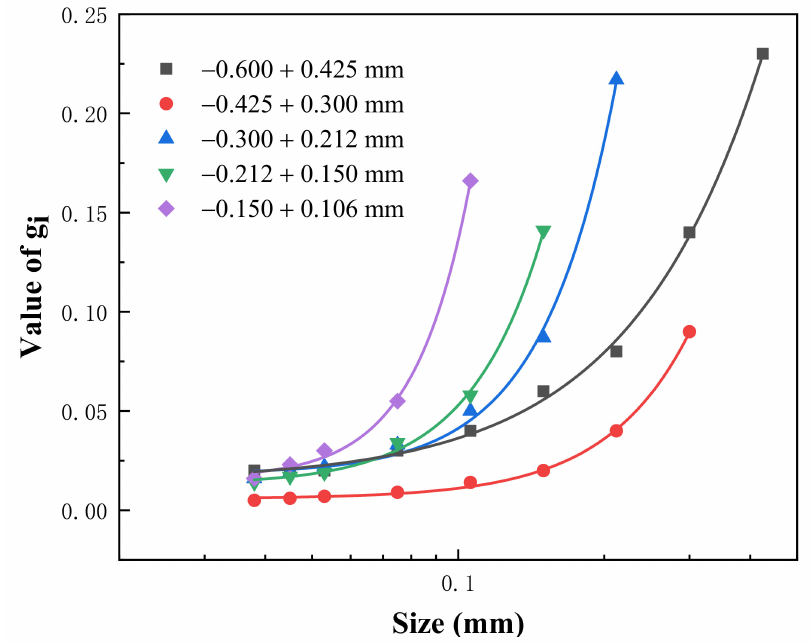
Figure 7. Variation characteristics of g i in daughter fractions.